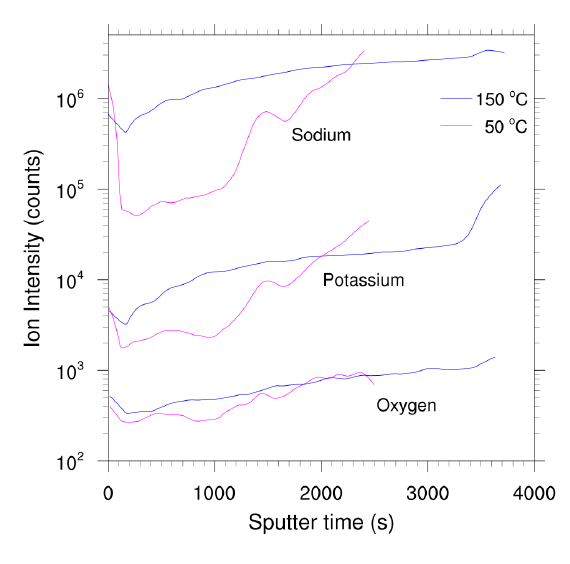
Figure 6. SIMS profiles of oxygen, potassium, and sodium for the Mo thin films deposited at 50 ◦ C and 150 ◦